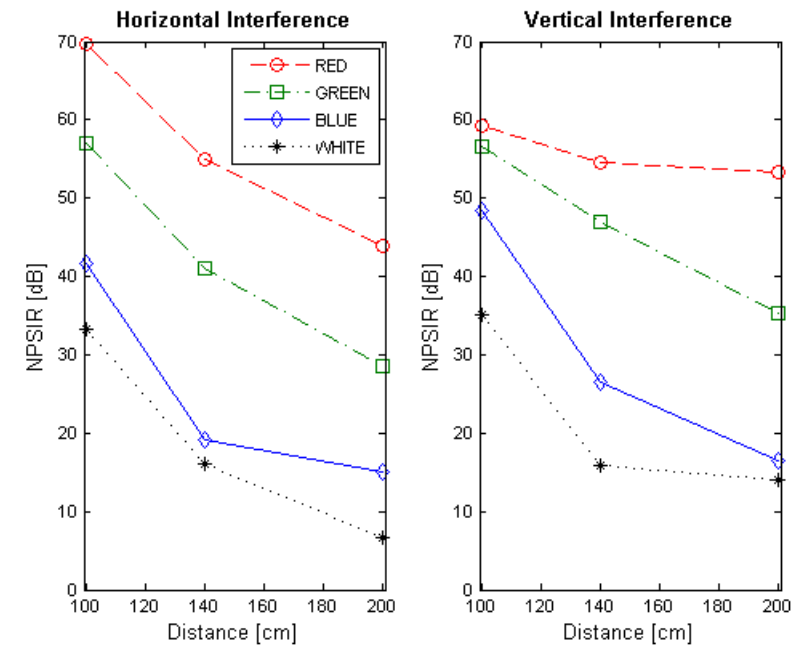
Figure 13. Normalized Power Signal to Interference Ratio for transmitting in blue. The left chart presents the interference of close emitters located on the same horizontal line. Right chart shows the interference of the transmitters within the same vertical